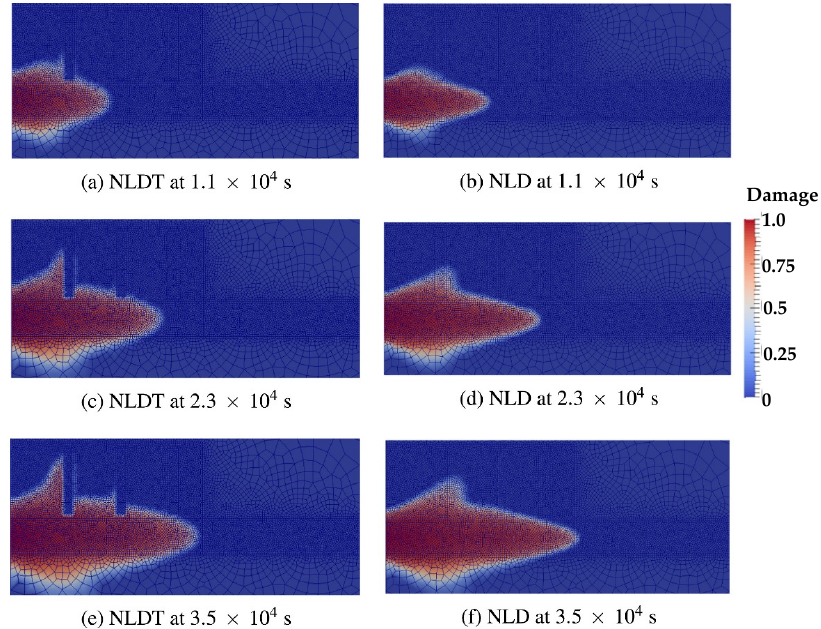
Figure 15. The fracture propagation characterized by the damage evolution (NLDT: non-local damage, non-local permeability; NLD: non-local damage, local permeability). Reprinted with permission from Ref. [251]. Copyright 2018, Elsevier.